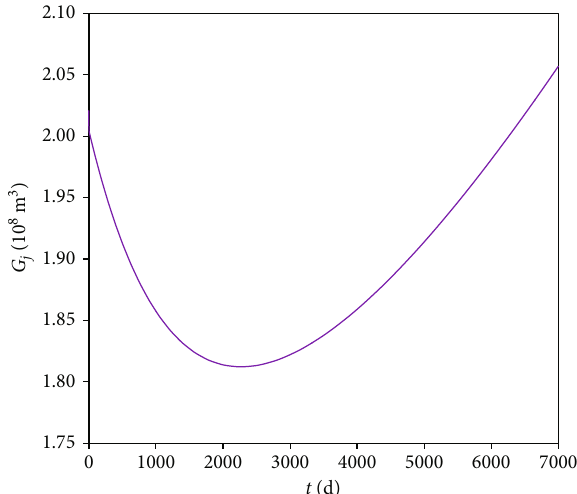
Figure 16: The estimated pro fi le of G